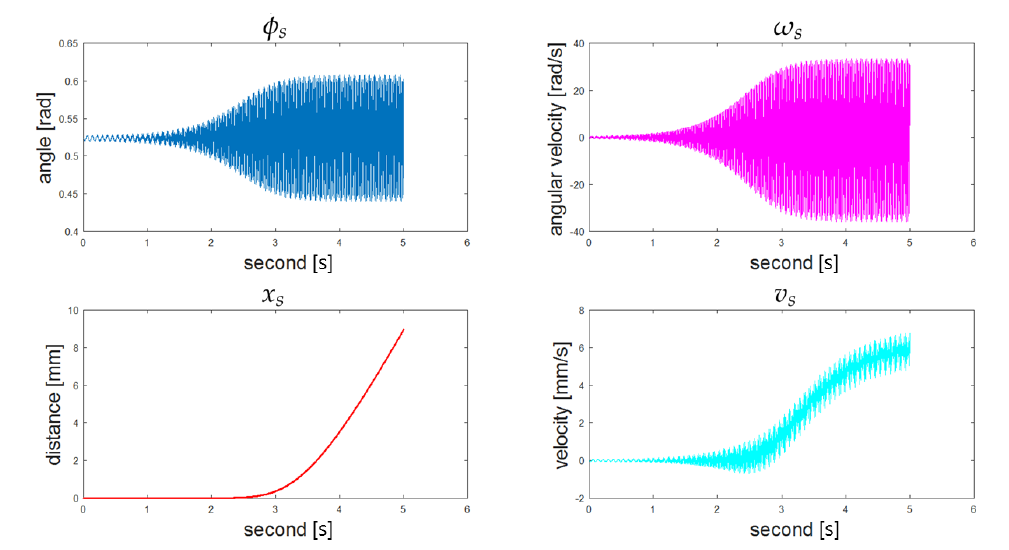
Figure 6. Simulation result plots of φ s , ω s , x s , v s under the given conditions Ω = 80 rev/s and µ ∗ = 0.259.